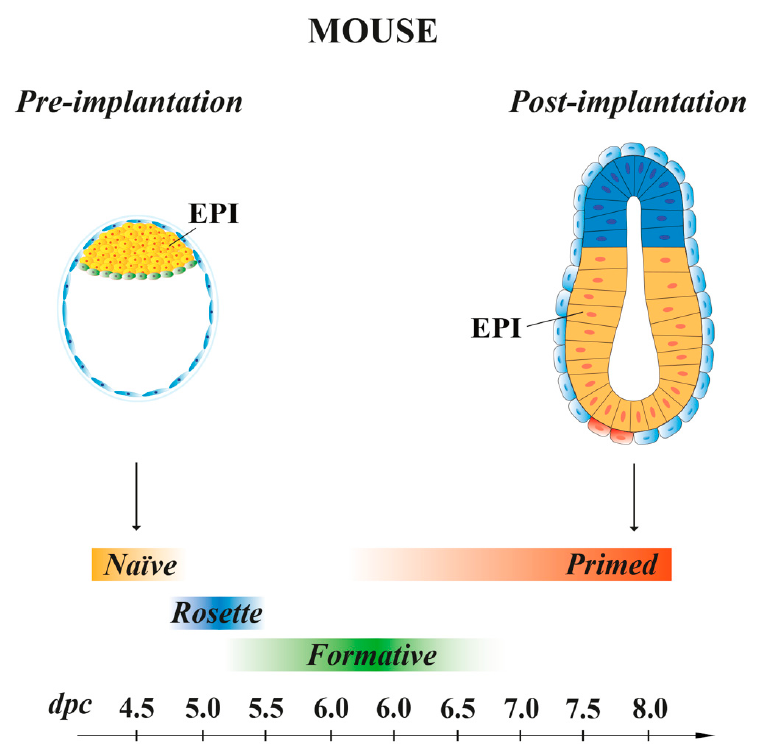
Figure 4. Pluripotency status of stem cells (SCs) derived from 4.5–8 days post coitum (dpc) embryos. ESCs derived from the mouse blastocyst have a naïve pluripotency; EpiSCs derived from post-im-